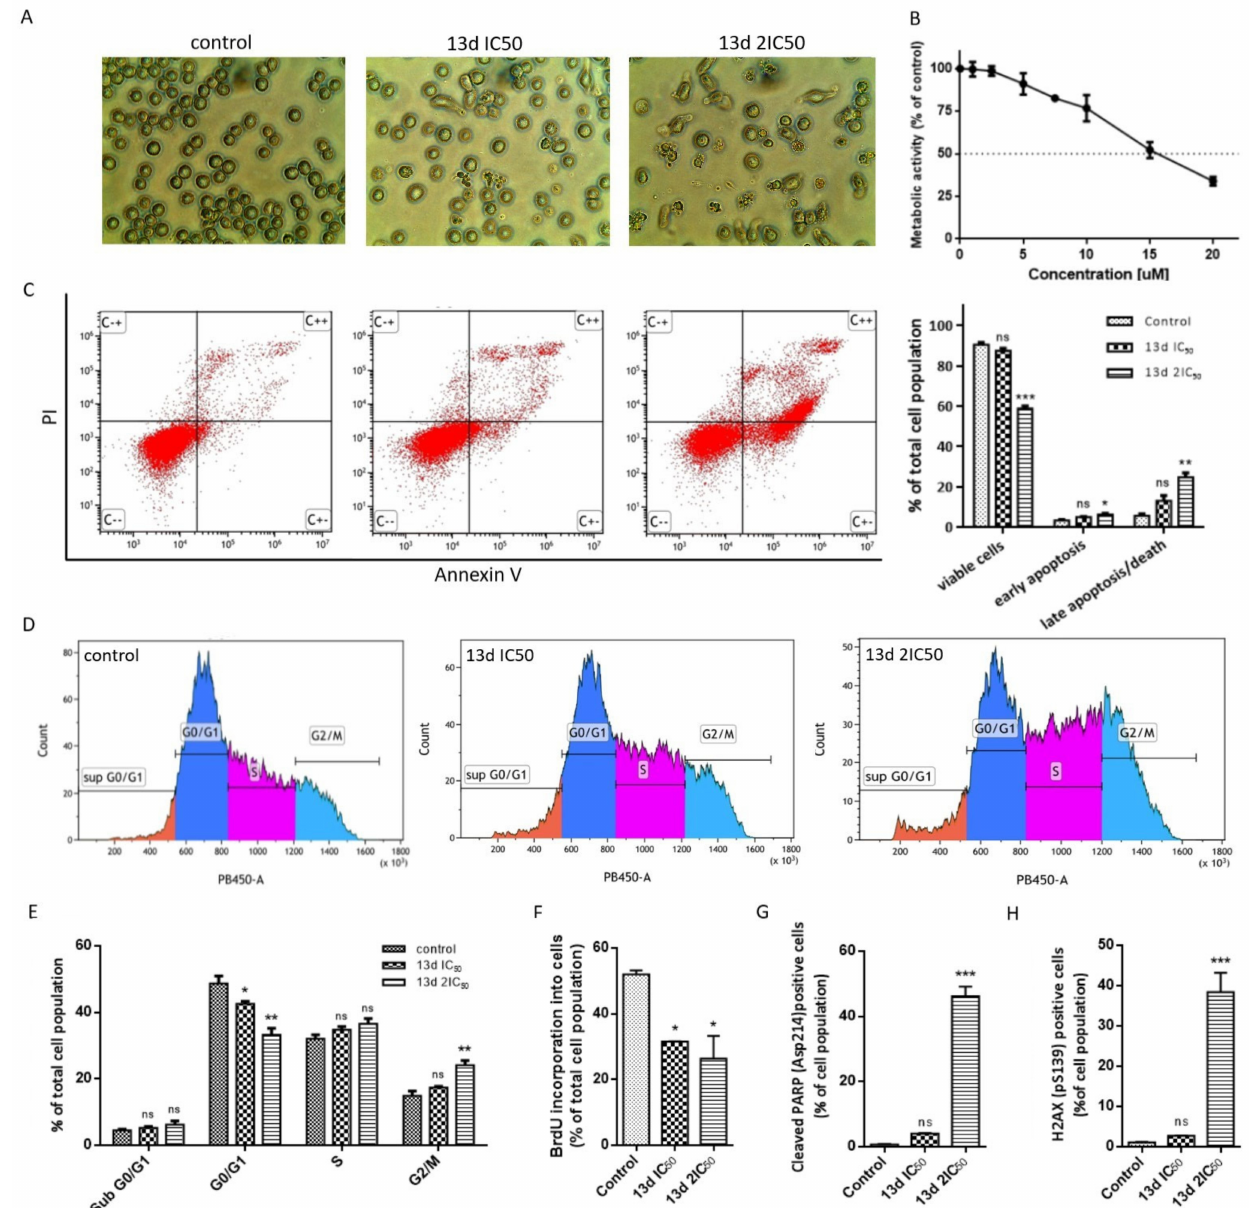
Figure 5. Effect of 13d on HL-60 cells after 24h incubation. ( A ) Morphological changes of HL-60 cells treated with 13d at IC 50 and 2IC 50 concentrations observed under a light microscope. ( B ) Metabolic activity of HL-60 cells treated with increasing concentrations of 13d assessed by MTT assay. ( C ) HL- 60 cells treated with 13d at IC 50 and 2IC 50 concentrations stained with Annexin V and PI were analyzed by flow cytometry. ( D – H ) Cells treated with 13d at IC 50 and 2 IC 50 concentrations were stained with Anti-BrdU, Anti-Cleaved-PARP (Asp214) and Anti-H2AX (pS139) antibodies and DAPI solution and analyzed by flow cytometry. The error bars represent means of three replicates ± SEM. ns—statistically non-significant; * p < 0.05, ** p < 0.01, *** p < 0.001 were considered significant in comparison to untreated